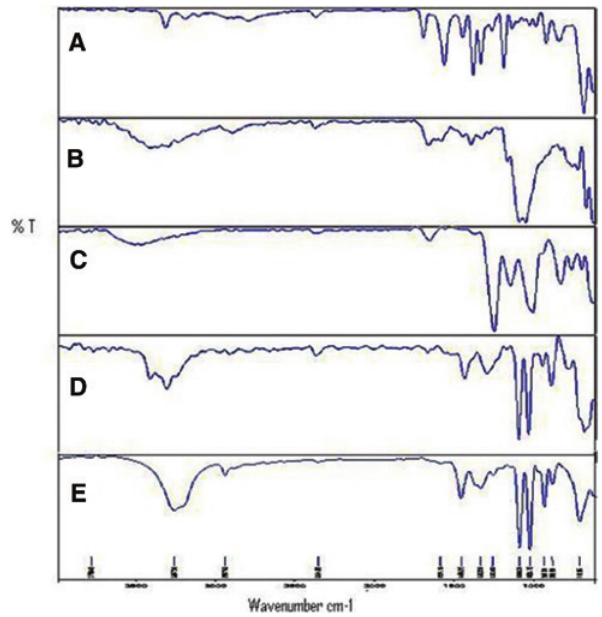
Figure 4: FTIR images of (A) drug, (B) DS, (C) CS, (D) mannitol, and (E) formulation.